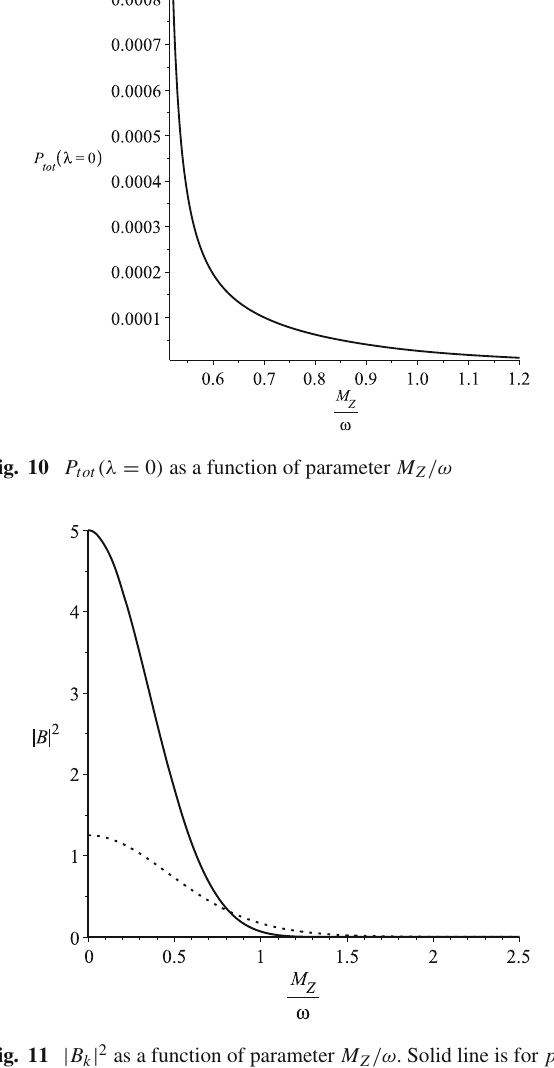
Fig. 11 | B k | 2 as a function of parameter M Z /ω . Solid line is for p = 0 . 5 , p (cid:11) = 0 . 4 , P = 0 . 1, while the point line is for p = 0 . 5 , p (cid:11) = 0 . 3 , P = 0 .